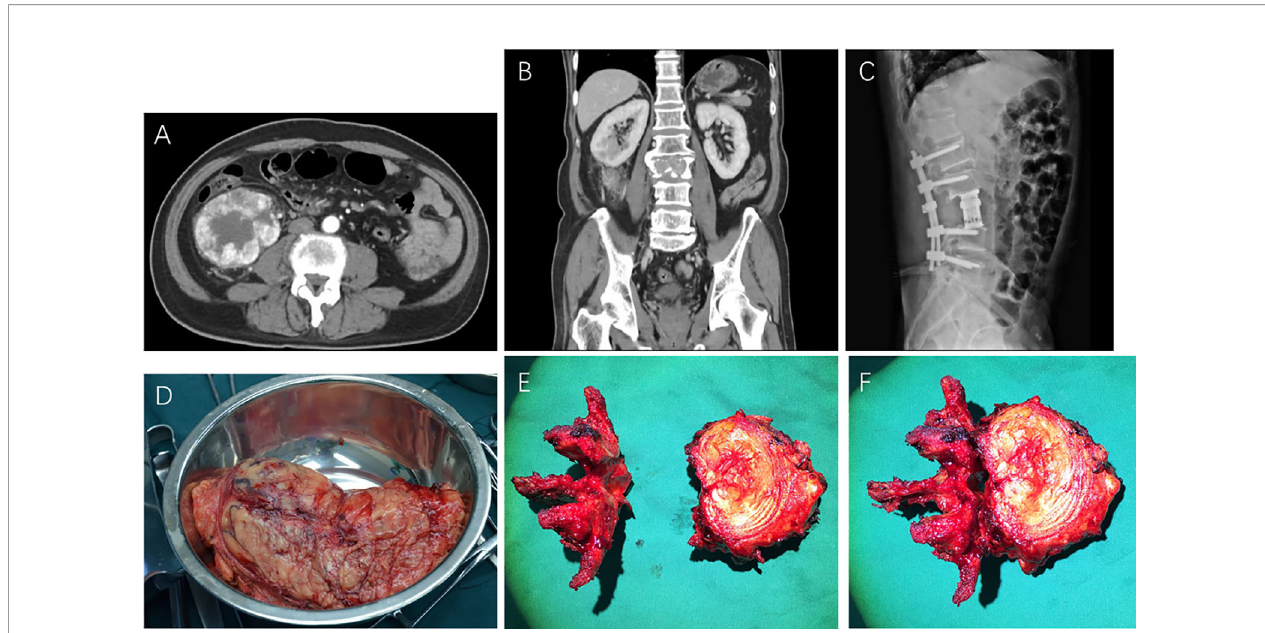
FIGURE 1 | Preoperative CT scans (A, B) , postoperative X-ray (C) , resected primary renal cell carcinoma specimen (D) , and en-block resected metastatic vertebra (E, F) of RCC with spinal bone